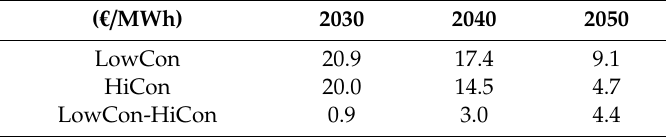
Table 4. Variable costs of electricity generation per MWh electricity produced in the ENTSO-E